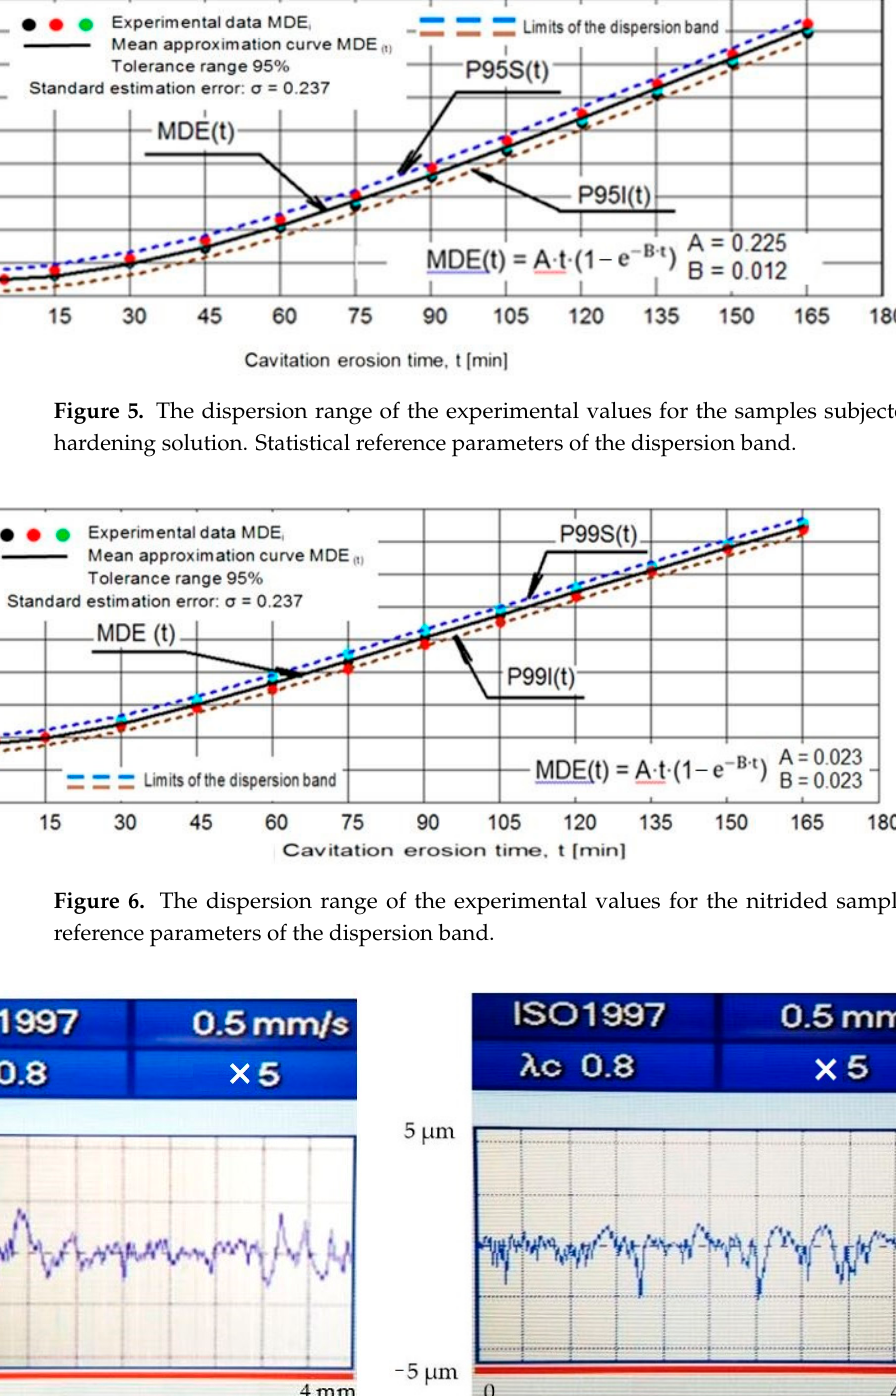
Figure 5. The dispersion range of the experimental values for the samples subjected to solution hardening solution. Statistical reference parameters of the dispersion band.